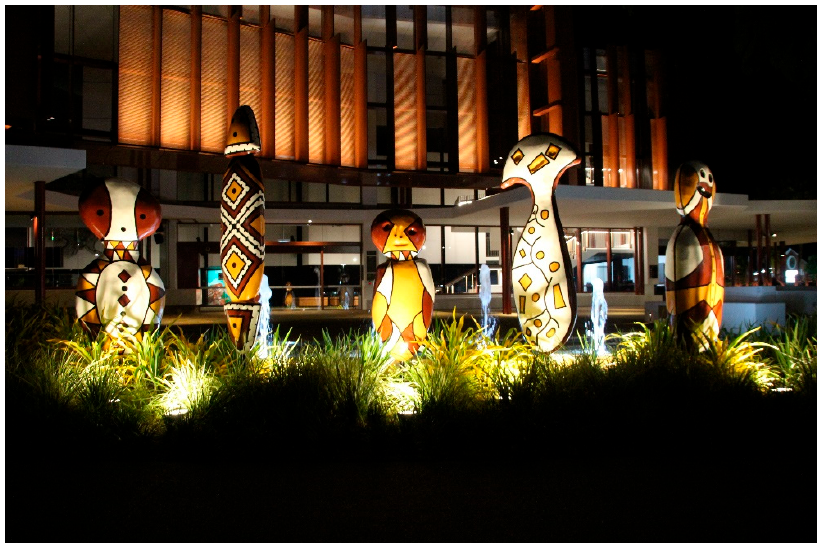
Figure 2. Example of unique Girringun art sculptures transformed into public art at Cairns Performing Arts Centre, installed 2018. Artists right to left Debra Murray and Emily Murray; Clarence Kinjun; Eileen Tep and Melanie Muriata; Sally Murray and John Murray; Philip Denham and Nephi Denham. Photography courtesy of Girringun Aboriginal Art Centre.